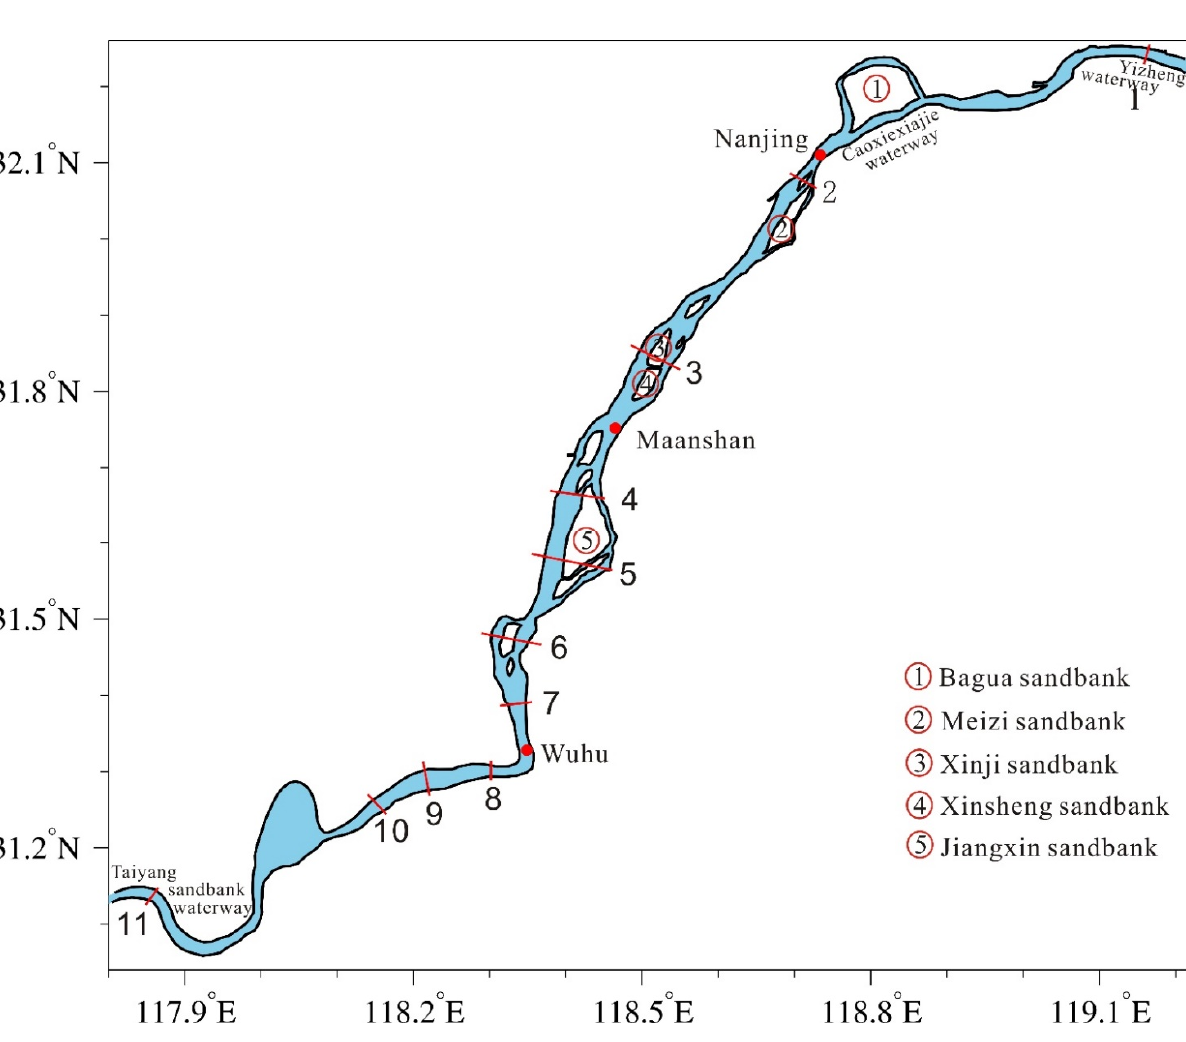
Figure 8. Tidal current limits under various guarantee rates of river discharge in the Changjiang River’s estuary in the dry season. The locations of sections 1–11 are the tidal current limits corresponding to the guarantee rates of 5–95% of river discharge.